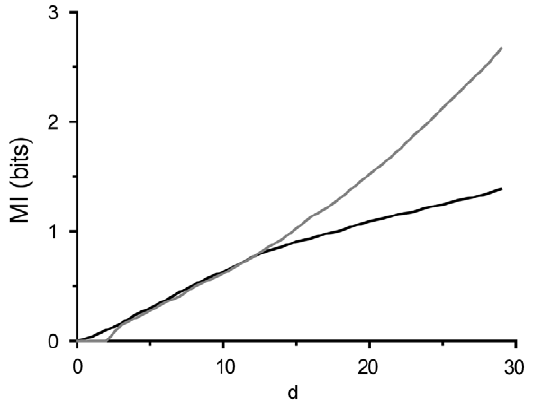
Figure 7. Climate data preprocessing. A , MI and information rate (dashed line) over four years of data; inset shows the fraction of missing data points occurring on either one (grey) or on both data series simultaneously (black). B , MI (black), information rate per sample (dark grey) or per minute (light grey) of 100,000 data points with different sample